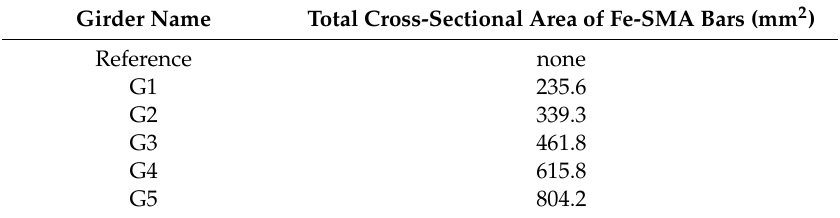
Table 4. Cross-sectional area of di ff erent configurations of Fe-SMA bars in girders.